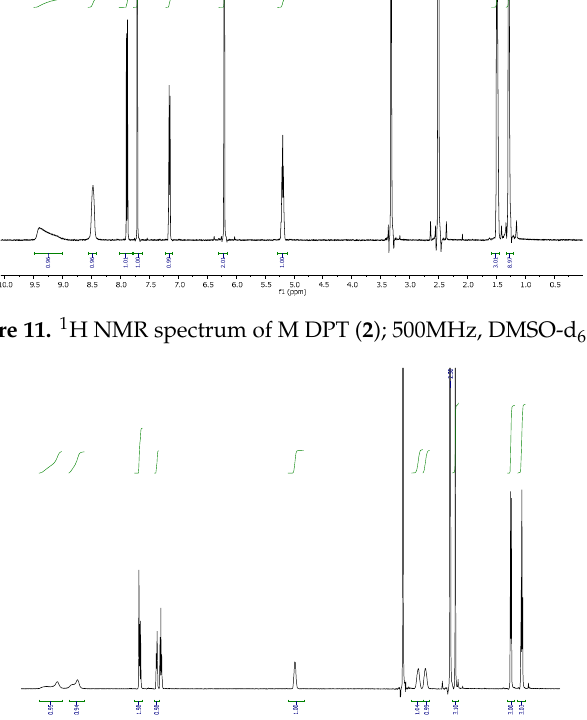
Figure 12. 1 H NMR spectrum of 3-MEC ( 4 ); 500MHz, DMSO-d 6 , RT.